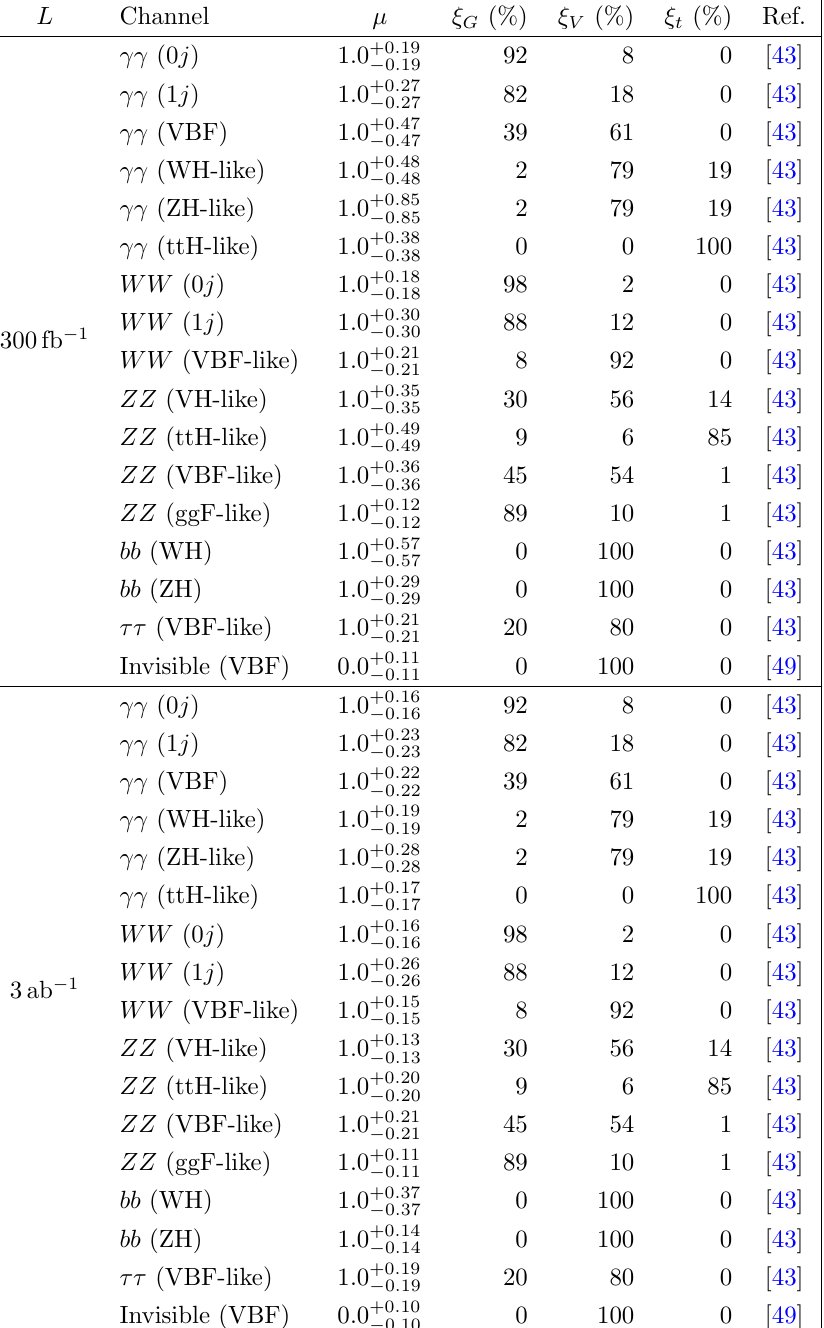
Table 4 . Projected ATLAS (CMS) Run 3 and Run 4 data used in (cid:12)ts from [43]. Data